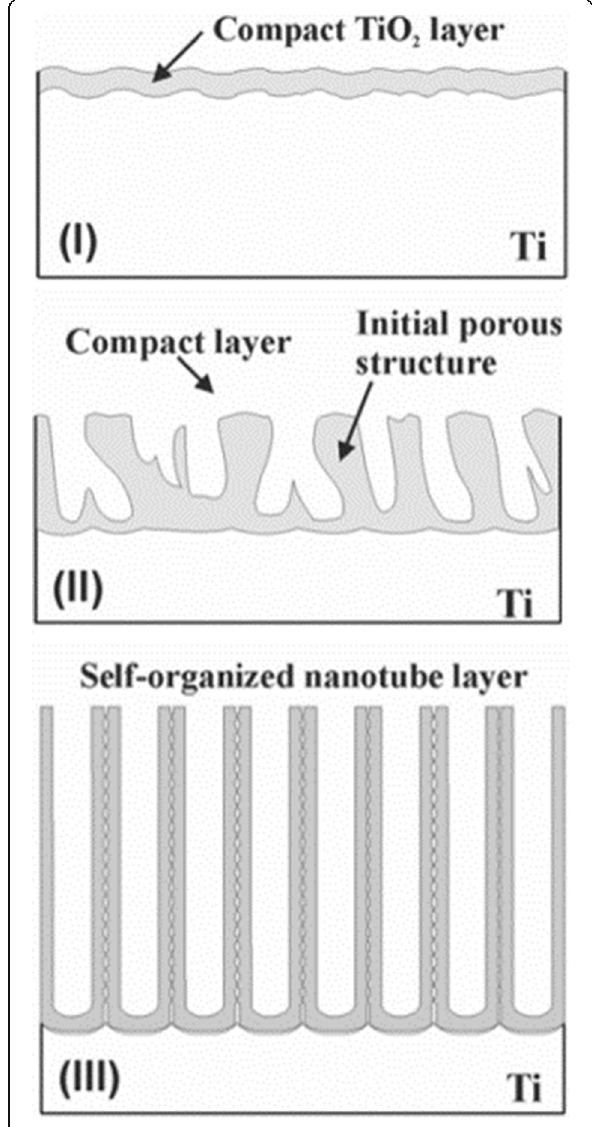
Fig. 7 The forming process of TiO 2 nanotube arrays. The formation of TiO 2 nanotube arrays can be divided into three different morphological stages ( I – III ). ( I ) A barrier oxide is formed. ( II ) The surface is locally activated and pores start to grow randomly. ( III ) Self-organized nanotube layer is formed reproduced from ref.